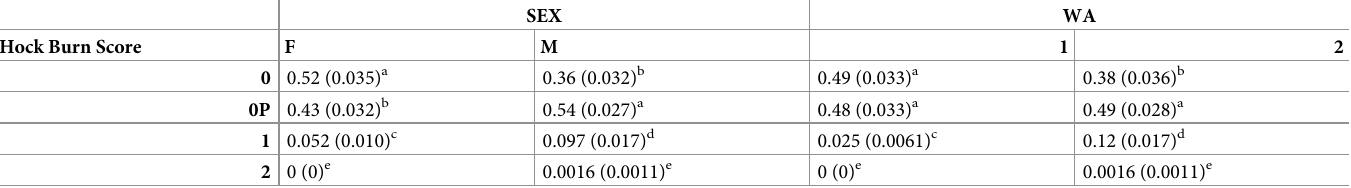
Table 8. The mean proportions of birds (SEM) which had each hock burn score for sex and welfare assessment (WA).